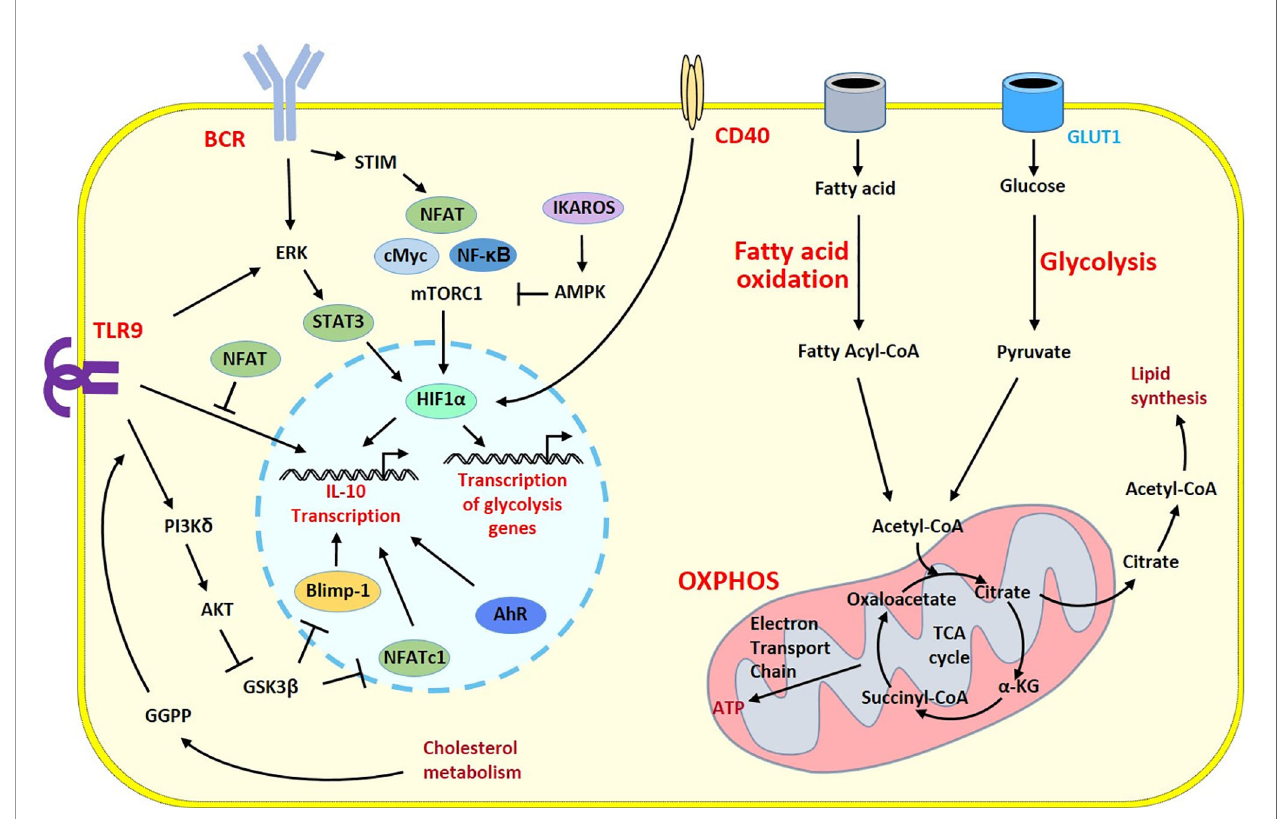
FIGURE 2 | Survey of metabolic programs in Breg cells. Metabolic and regulatory programs share common signaling cascades in B cells developing regulatory properties. Activation signals from the BCR and TLR9 induce different intracellular pathways triggering HIF-1 a a key player that govern transcription of the prototypic regulatory cytokine IL-10 gene and genes involved in the metabolic programs into the nucleus. The polarization into Breg cells is under the control of a number of transcription factors and enzymes having positive (pointed arrow) or inhibitory ( fl attened arrow) effects. Glycolysis has a central role to generate energy and biomolecules. Through the GLUT1 transporter, glucose fuels the TCA cycle within the mitochondria. During the TCA cycle, energy is generated through oxidative phosphorylation and fatty acid oxidation brings additional substrates to the TCA cycle and increases lipid synthesis. One intermediate of this pathway, the GGPP molecule produced during cholesterol metabolism induces Blimp1 another key transcription factor of the Breg program following TLR9 stimulation leading to enhanced IL-10 production. The co-stimulatory CD40 molecule can also stimulates HIF-1 a to circumvent the BCR-dependent cascade and contributes to the Breg polarization. a -KG, a -ketoglutarate; AMPK, AMP-activated protein kinase; ATP, adenosine triphosphate; BCR, B cell receptor; GGPP, geranylgeranyl pyrophosphate; GSK3, glycogen synthase kinase 3; OXPHOS, Oxidative phosphorylation; STIM, stromal interaction molecule; TLR, Toll-like